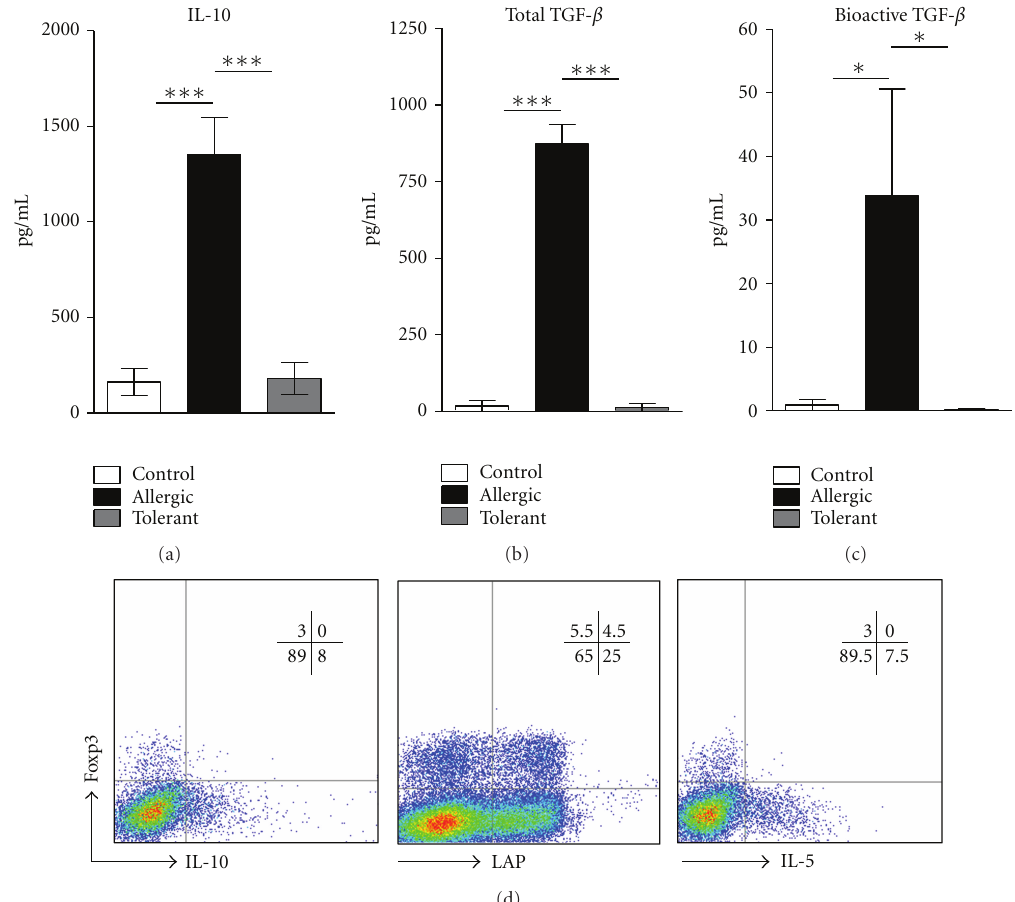
Figure 5: Regulatory T cells are not the major producer of suppressive cytokines in the BAL. Quantification by ELISA of BAL (a) IL-10, (b) total, and (c) bioactive TGF- β of BALB/c control, allergic and tolerant mice upon 24h of the last OVA challenge. (d) IL-10, LAP, and IL-5 staining of BAL CD4 + Foxp3 + cells from allergic mice. Pooled cells recovered from BAL of five allergic mice were stained for CD4, Foxp3, IL-10, LAP, and IL-5 and gated in CD4-positive cells. Values represent the means ± SEM for groups of five mice and are representative of two experiments. Significant di ff erences ∗ P < 0 . 05, ∗∗∗ P < 0 . 05 are